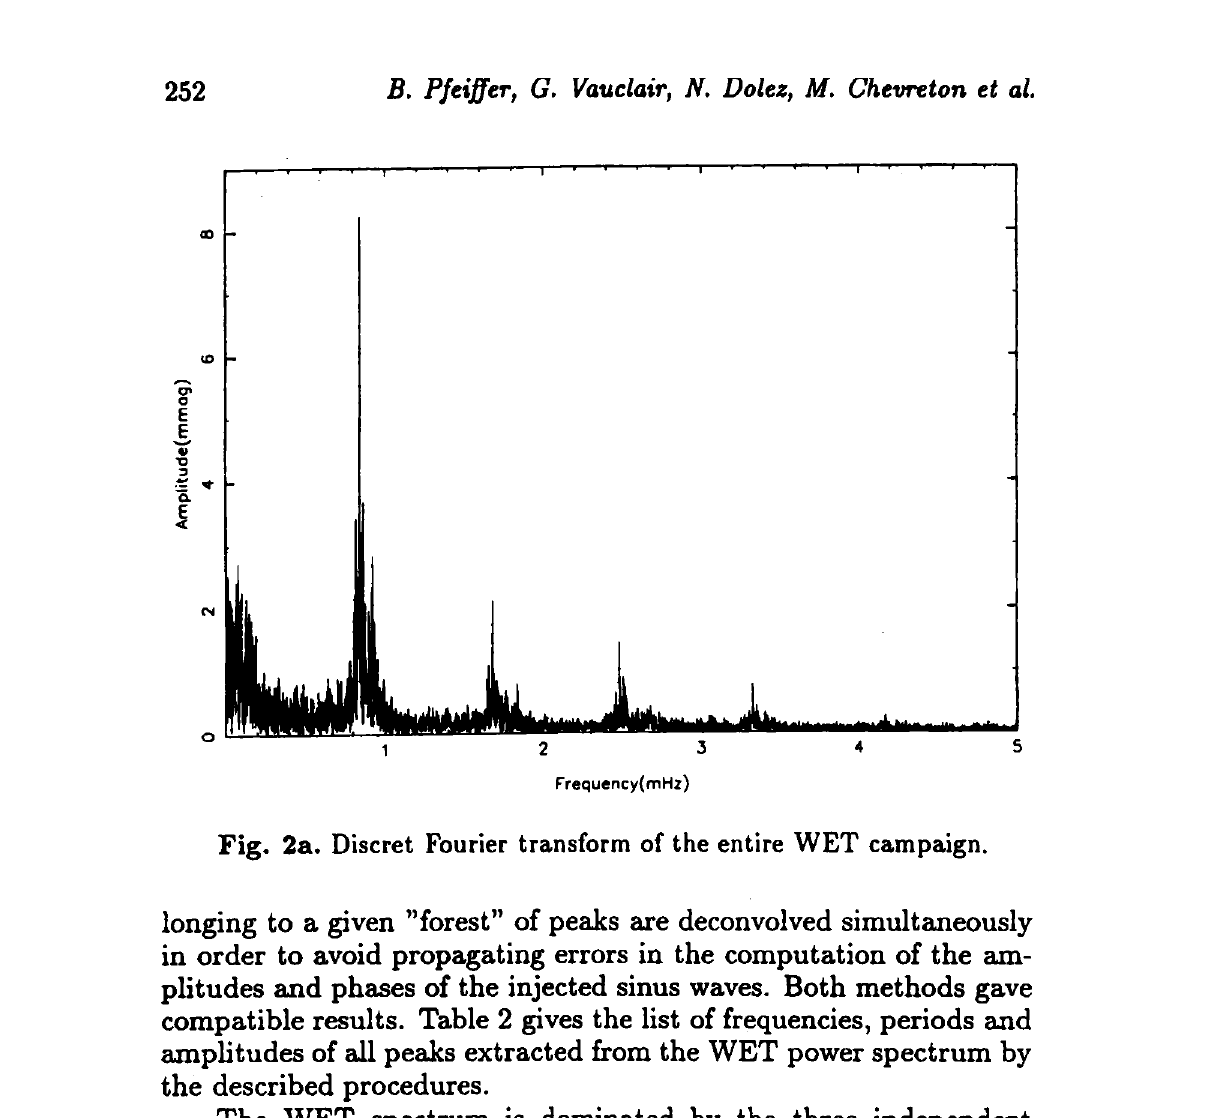
Fig. 2a. Discret Fourier transform of the entire WET